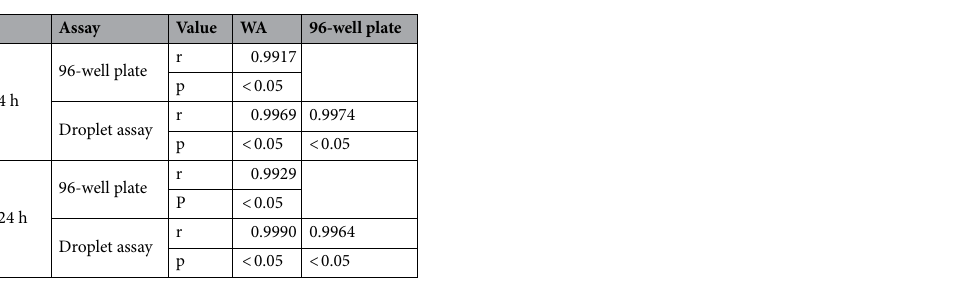
Table 3. Pearson correlation among three different antifungal assessment assays against A. alternata after 4 h and 24 h of incubation. Correlation (r) is significant at P < 0.05; Statistix 8.